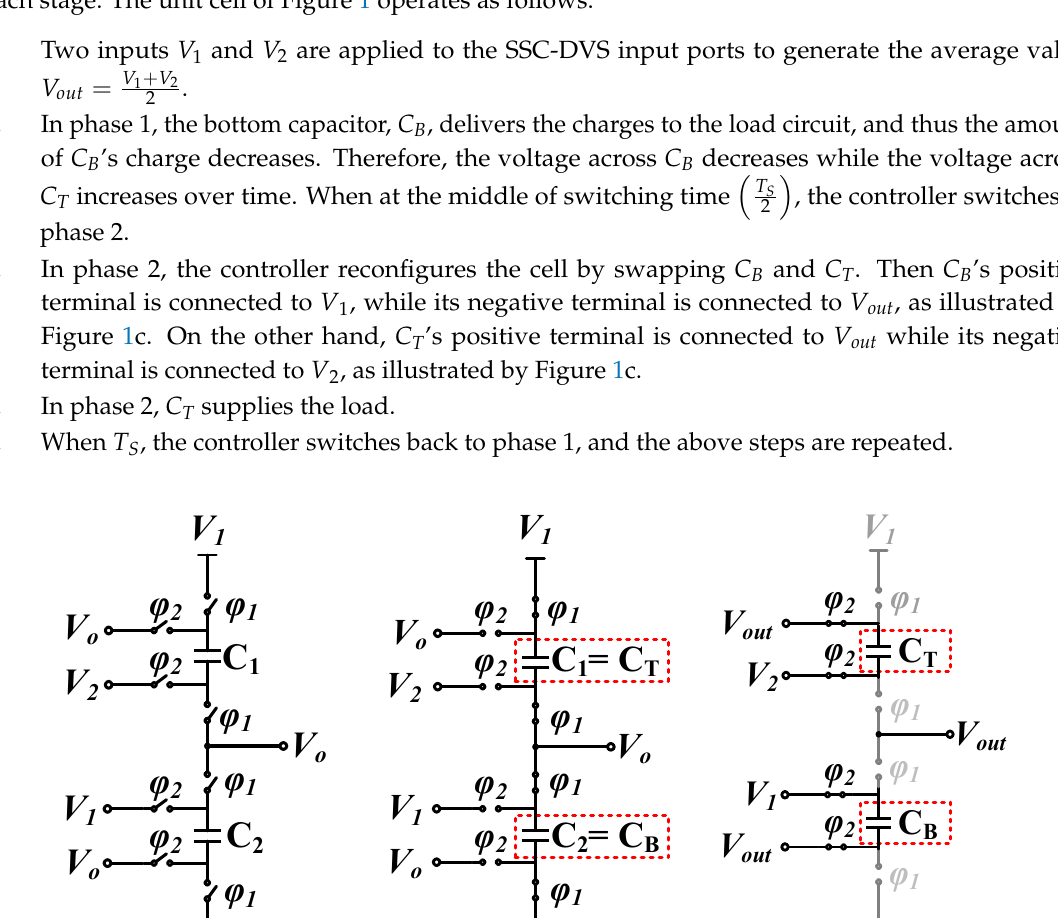
Figure 3. The schematic diagram for the proposed n -bit SSC-DVS architecture. Figure 4. Transmission-gate switch with body switch that was used in the proposed SSC-DVS. In the second configuration of Figure 7, we applied D 1 D 2 = (01) 2 to generate conversion ratios of (cid:2869) (cid:2870) and (cid:2871) (cid:2872) . Figure 7 shows phases φ 1 and φ 2 to configure the switches of the swapping process to generate conversion ratios of (cid:2869) (cid:2870) and (cid:2871) (cid:2872) . We connected inputs V 1 and V 2 of the first stage to V in and GND , respectively, resulting in 𝑉 (cid:3042)(cid:3048)(cid:3047)(cid:2869) = (cid:3023) (cid:3284)(cid:3289) (cid:2878)(cid:3008)(cid:3015)(cid:3005) (cid:2870)